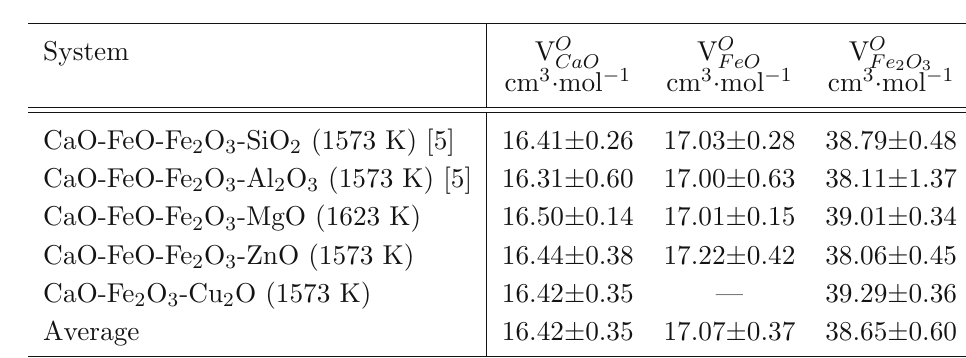
Table 7 Molar volumes of pure oxides calculated from individual independent systems.